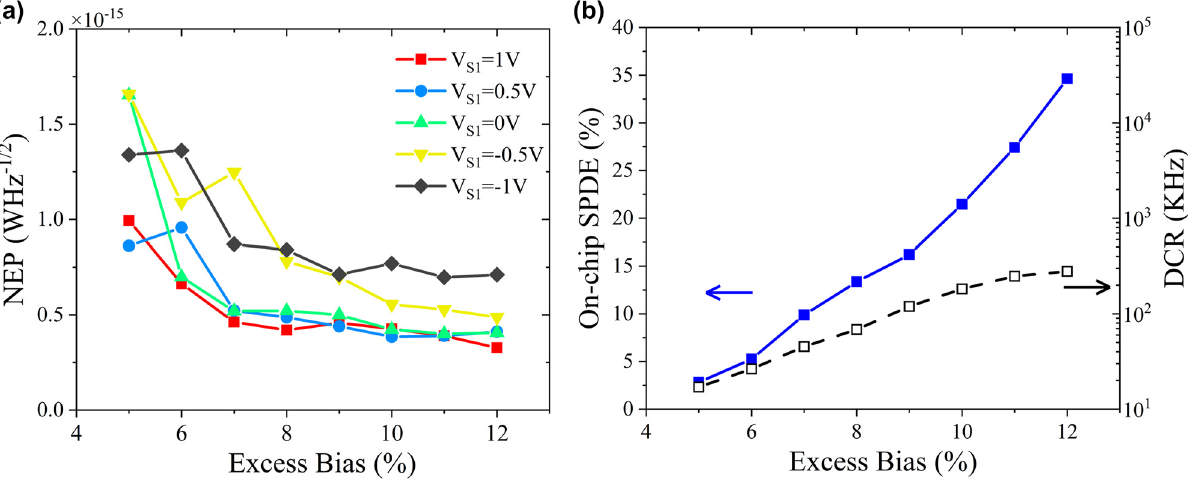
Figure 7: NEP and the best DCR and SPDE of the detector. (a) NEP versus excess bias with different voltage at 78 K. (b) The best feature of DCR and = 1 SPDE curve with applied voltage V S1